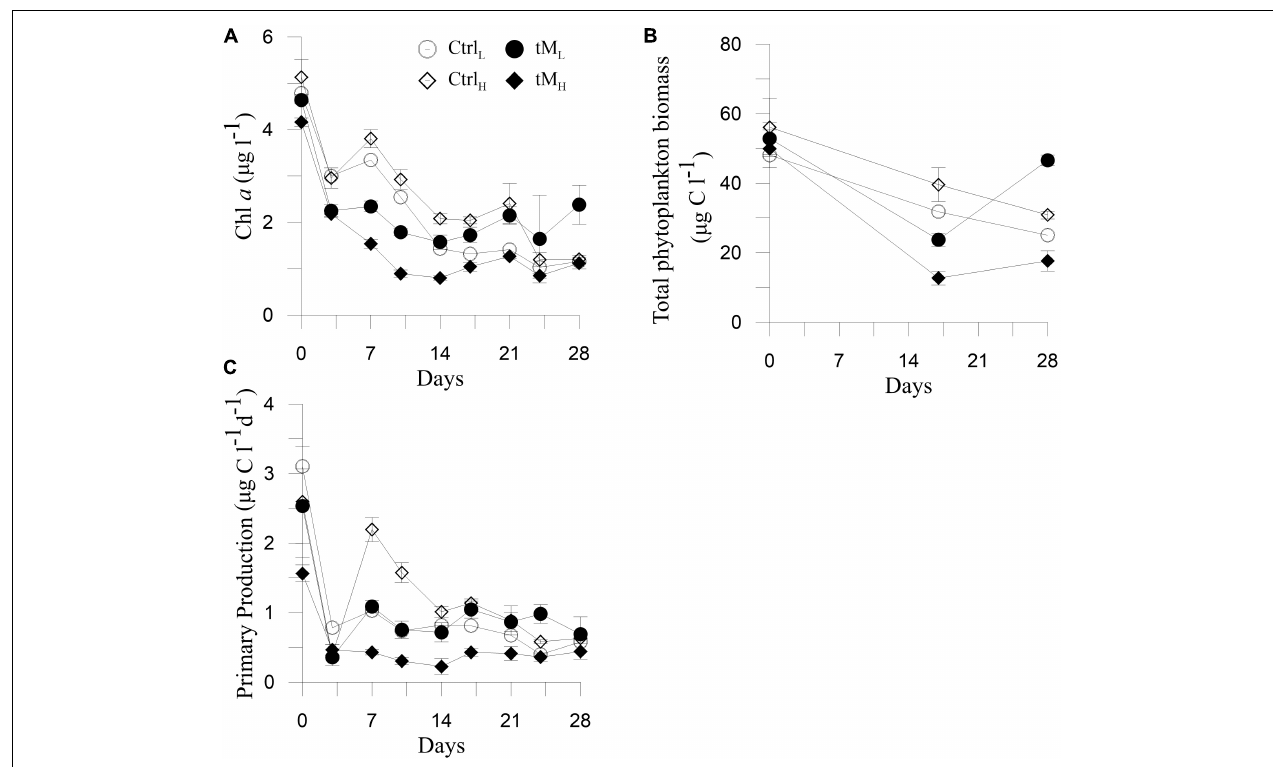
FIGURE 6 | Temporal variation of Chl a (A) modified from Traving et al. (2017), total phytoplankton biomass (B) and primary production (C) . Means ± standard error, n =